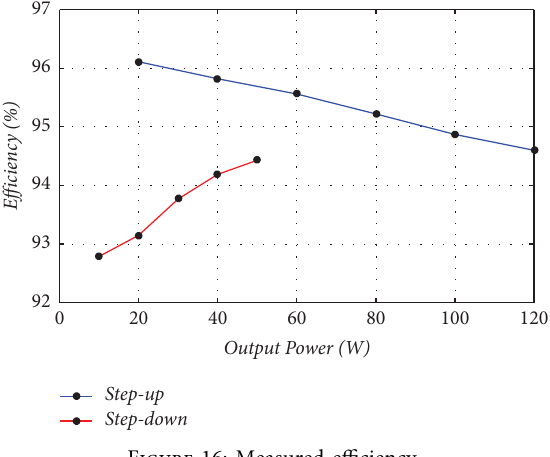
Q 1 , (b) V Q 2 , (c) V Q 3 , and (d) V o .